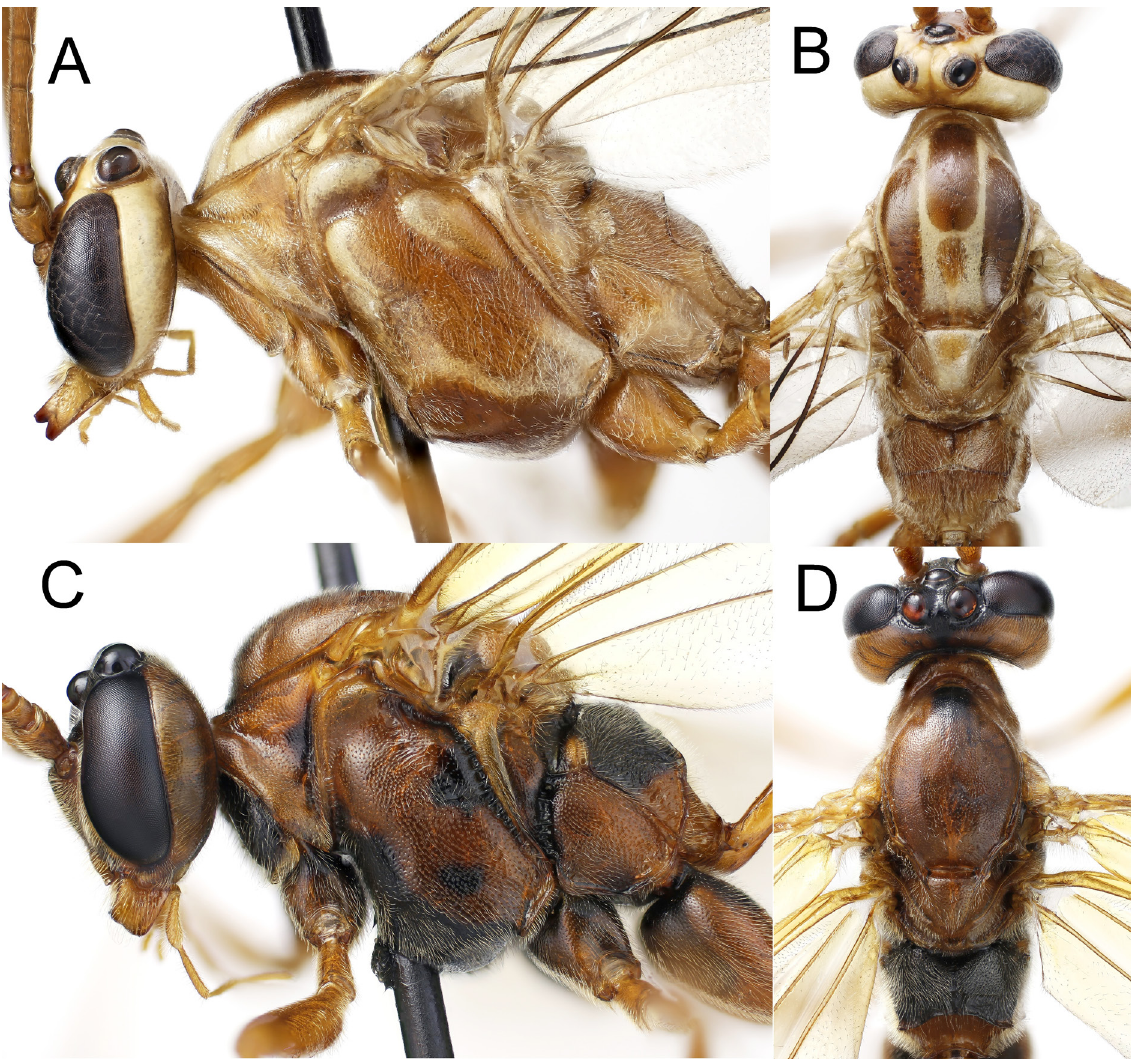
Fig. 11 . head and mesosoma, lateral and dorsal view of female. A‒B . Ophion variegatus rudow,